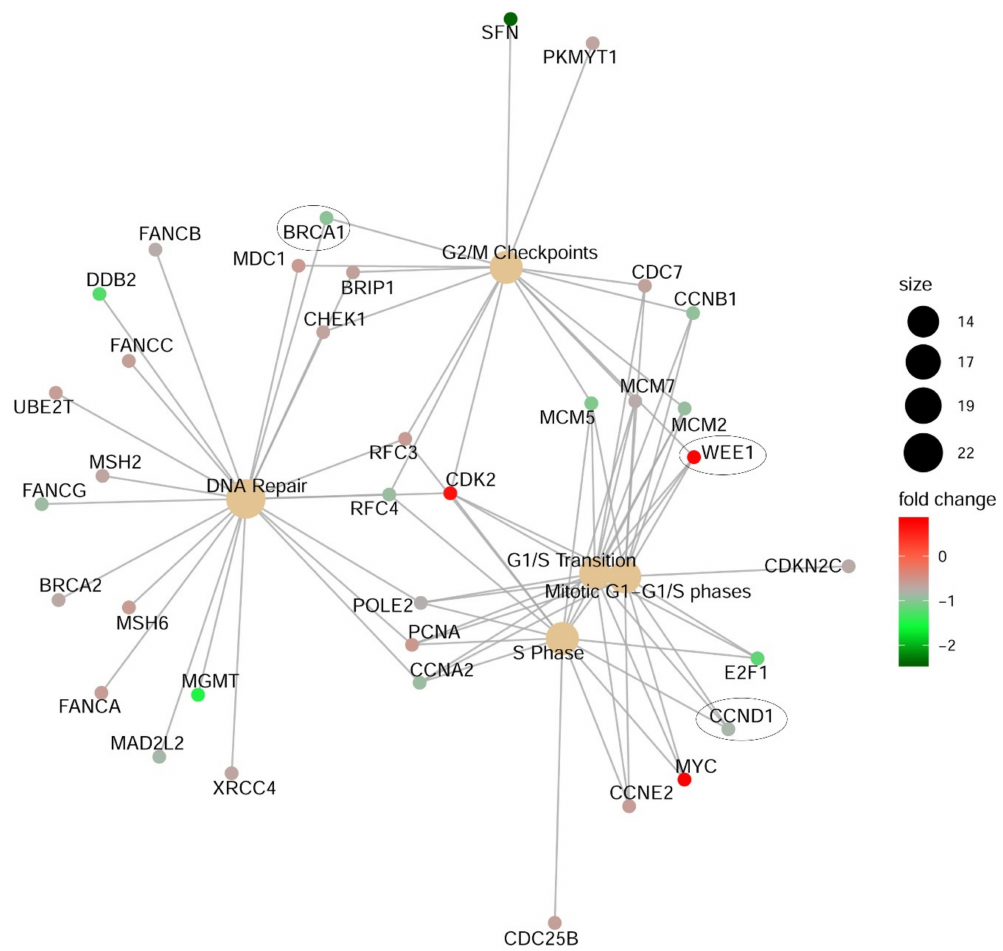
Figure 4. Signaling pathway nodes e ff ected by loss of CDK11 in A375 melanoma cells following PanCancer Reactome pathways analysis. A375 cells were transfected with siRNA directed against CDK11 or control siRNA. After 48 h, cells were collected for RNA purification. Gene names with an ellipse drawn around them represent genes that were similarly altered in both A375 and WM1366 cells after q-RT-PCR verification. Fold change in gene expression is indicated by the red (increased) to green (decreased) scale shown. Node circle size represents the number of genes altered in that